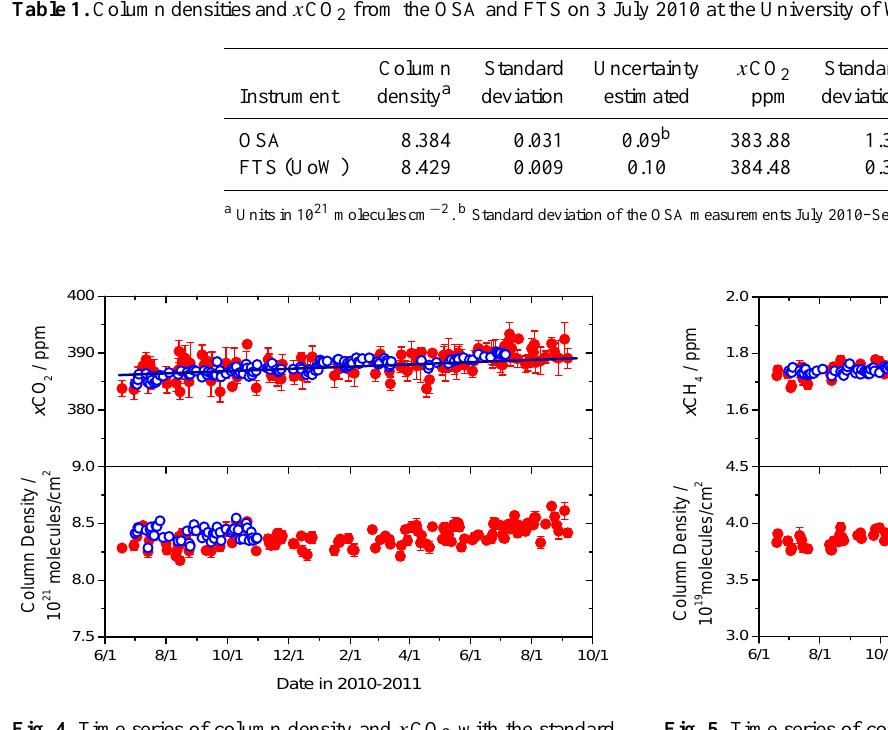
buried in the measurement